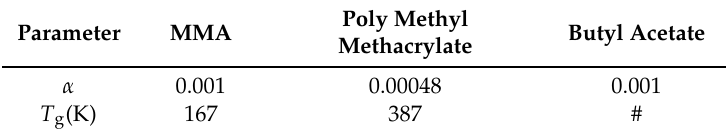
Table 1. Parameters for Methyl methacrylate gel and glass affect